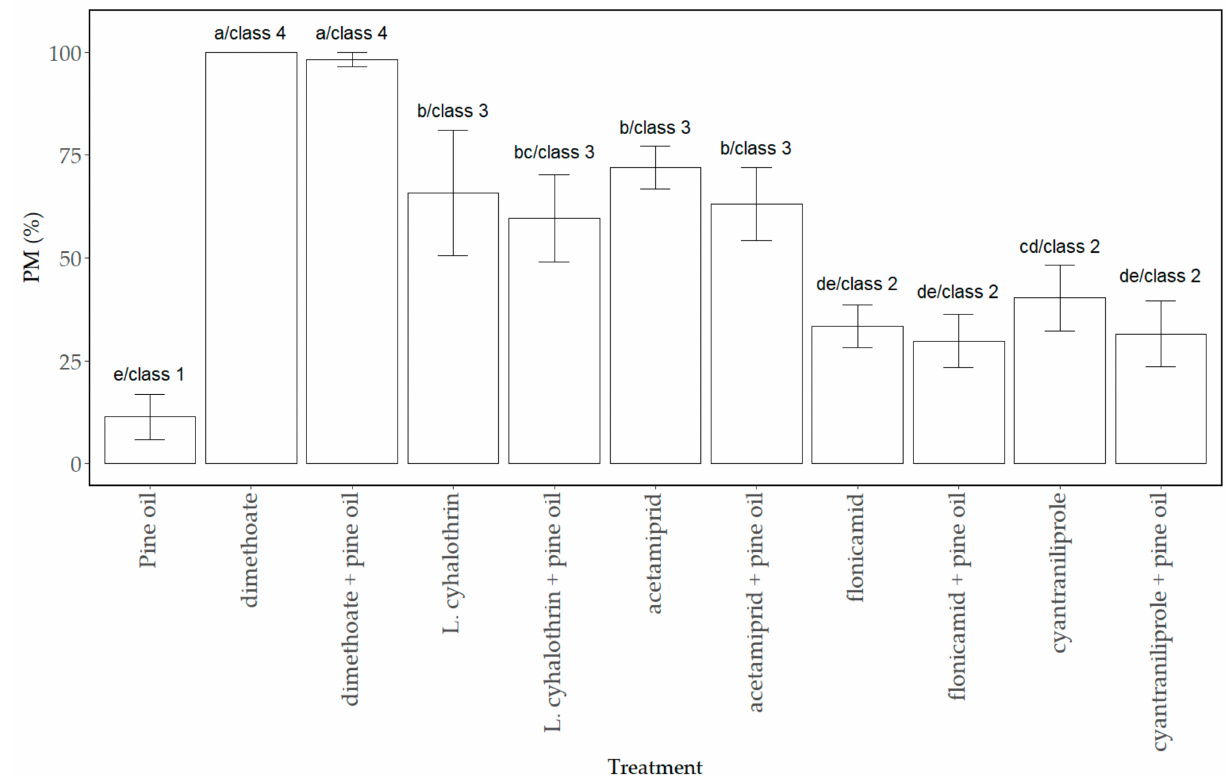
Figure 2. Effect of insecticides and their combination with a pine oil based organic adjuvant on T. dryi pupae under laboratory conditions. Colums with different letters are significantly different among the treatments tested (Fisher’s LSD test, p < 0.05) and with different class numbers are IOBC/WPRS class based on parasitoid mortality: Class 1 = PM < 25% (harmless): Class 2 = 25 ≤ PM ≤ 50% (slightly harmful); Class 3 = 51 ≤ PM ≤ 75% (moderately harmful); and Class 4 = PM > 75% (harmful) [57–59]. PM: percentage of corrected mortality; SE: standard error; L. cyhalothrin: lambda-cyhalothrin. Values are expressed as the mean of PM (%) ± SE at 7